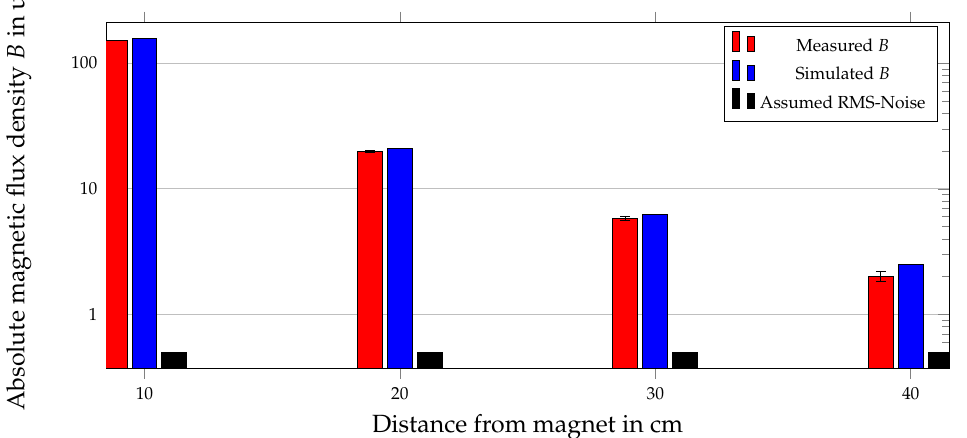
Figure 11. Absolute magnetic flux density B depending on the distance from the magnet. The mea- sured magnetic flux density and its standard deviation (STD) are compared with the simulated one from COMSOL. Moreover, the assumed RMS-noise is depicted.